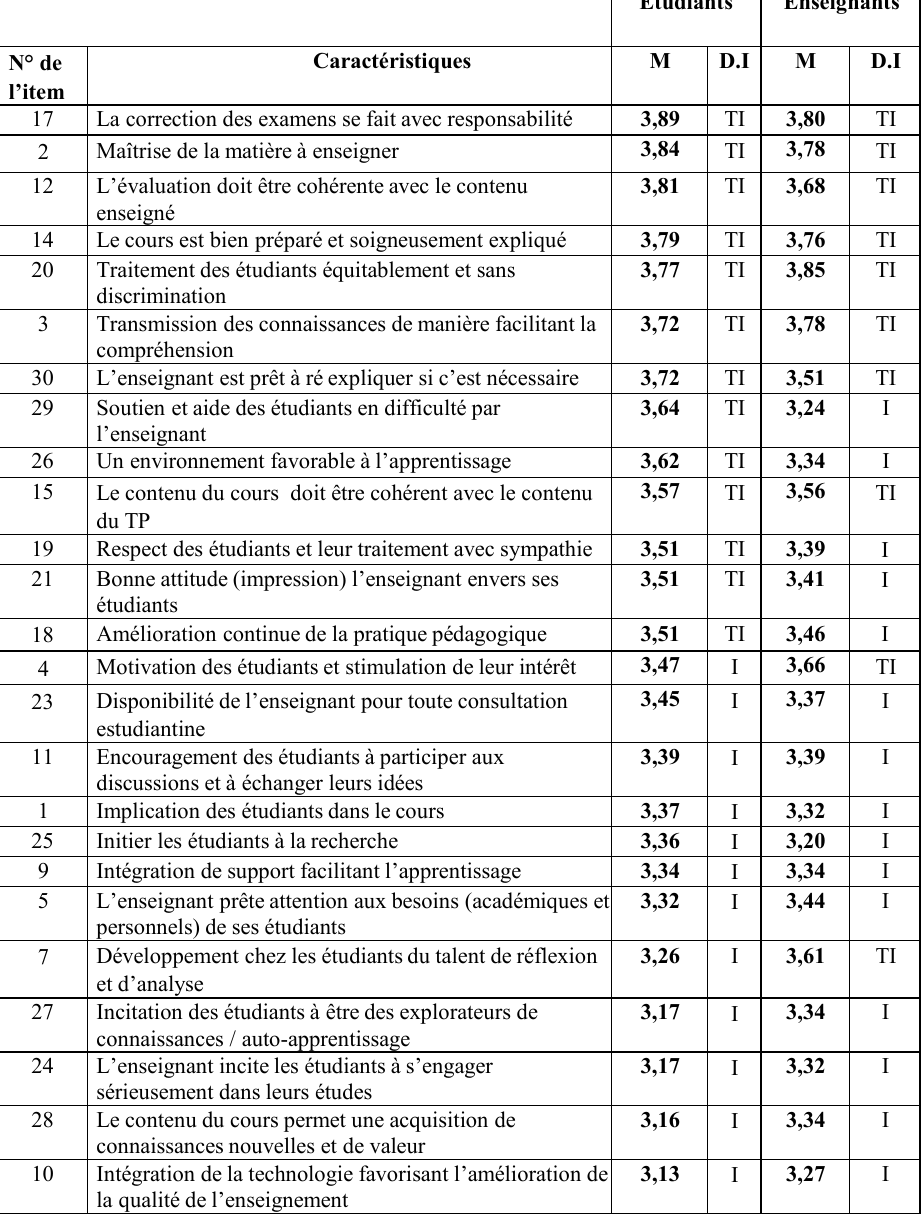
Tableau 2 : Degré d'importance des 30 caractéristiques de l’enseignement efficace selon les points de vue des enseignants et des étudiants